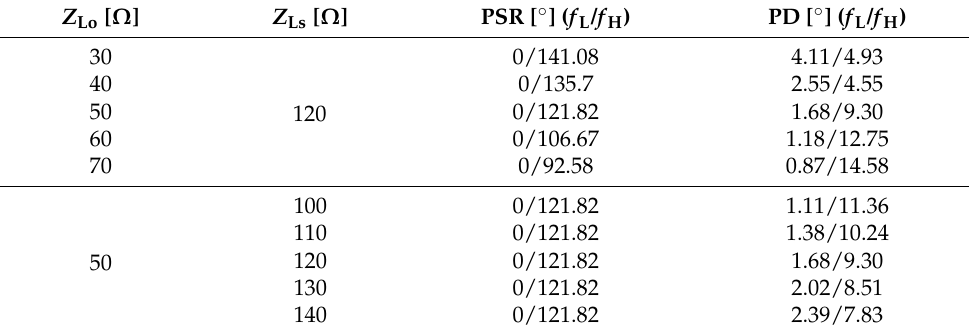
Figure 7. PSR with and without compensating for the effects of a λ /4 shunt open stub at the high band. 3. Simulation and Measurement Results The proposed dual-band tunable PS was designed and fabricated at f L = 1.88 GHz and f H = 2.44 GHz with an operating bandwidth of 100 MHz, using a substrate RT/Duroid 5880 with a dielectric constant ( ɛ r ) of 2.2 and a thickness ( h ) of 0.787 mm. The simulation was performed by using advanced design system (ADS) simulator. The variable capaci- tance C v was implemented using a varactor diode SMV-1231 from SKYWORKS. A 3-dB hybrid coupler S03A2500N1 from ANAREN was also used. Figure 8 shows a layout and photograph of the designed dual-band tunable PS.